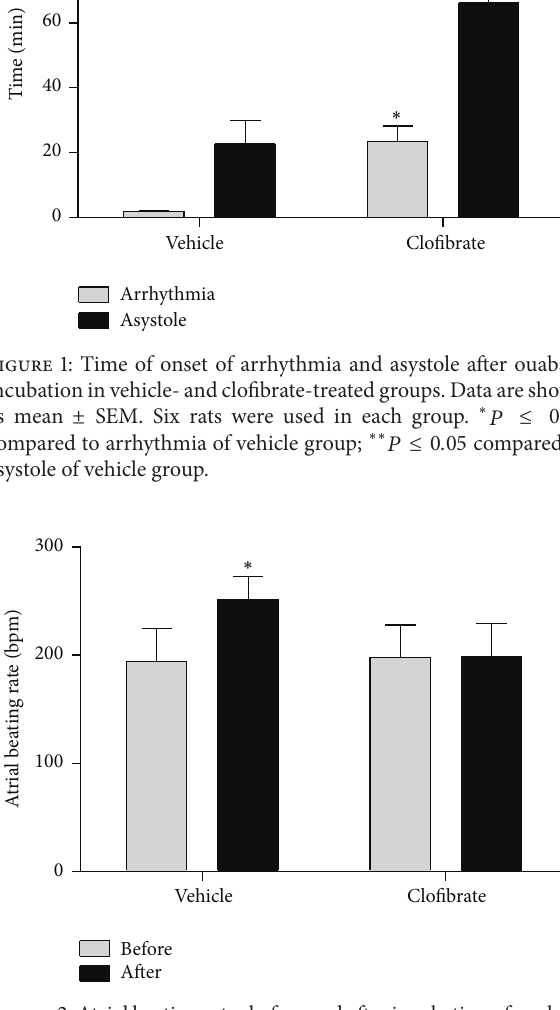
Figure 2: Atrial beating rates before and after incubation of ouabain in vehicle- and clofibrate-treated groups. Data are shown as mean ± SEM.Sixratswereusedineachgroup. ∗ 𝑃 ≤ 0.05 comparedtobefore time of vehicle group.